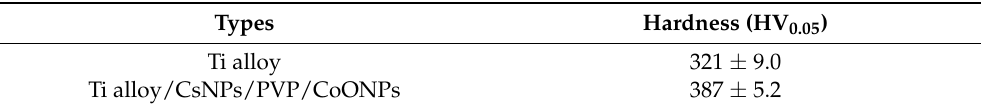
Table 4. The hardness of the Ti alloy before and after